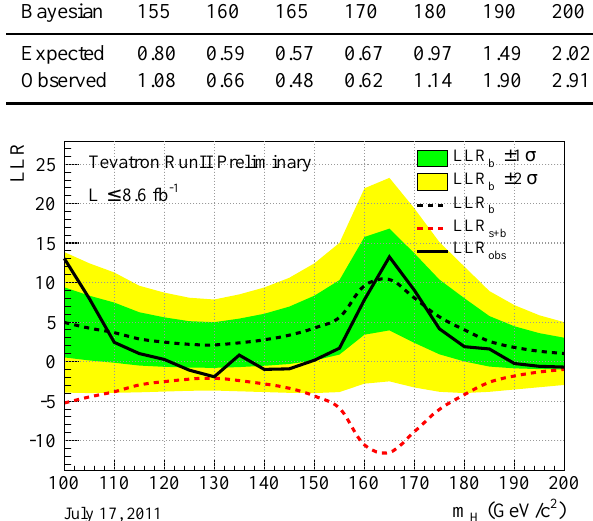
Fig. 4. Distributions of the log-likelihood ratio as a function of Higgs boson mass obtained with the CL s method for the Tevatron combination. The bands indicate the region enclosing 1- σ and 2- σ fluctuations of the background, respectively.